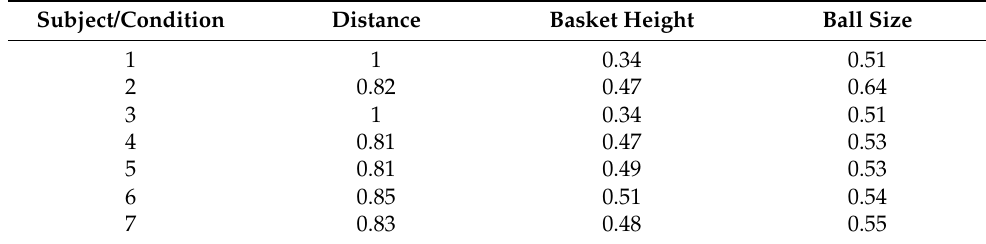
Figure 4. Distribution of all throws and conditions for subject 1.